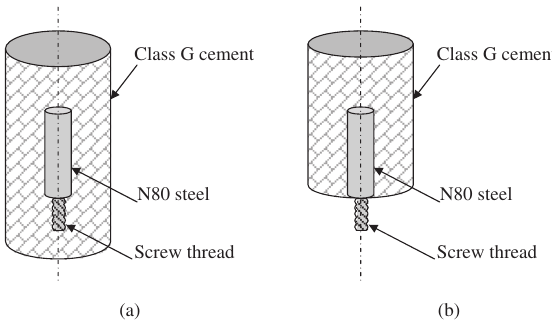
Figure 1: Schematic structure of the specimen. (a) Sample for exposure and (b) sample for property test.